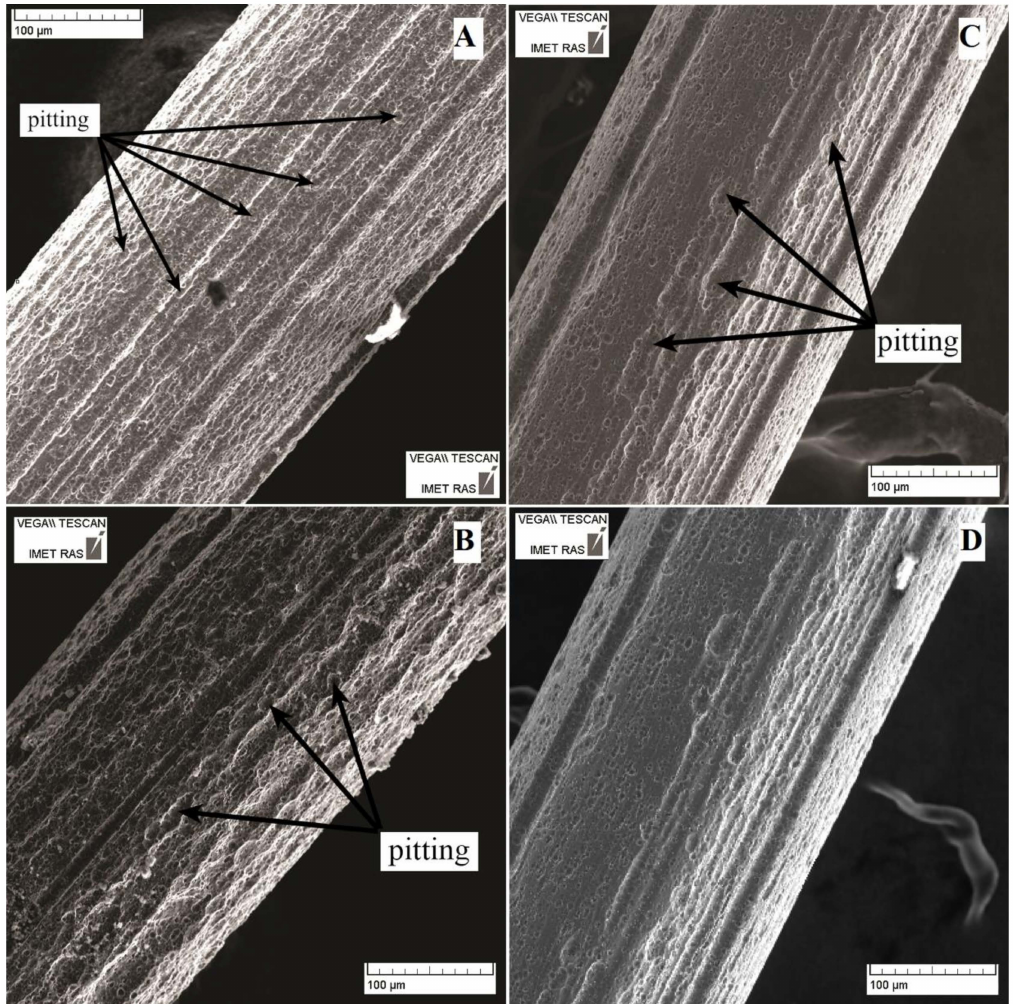
Figure 4. SEM image of the NiTi wire surface after two years of immersion testing in a bu ff er solution at pH 1.68 (Solution 1, Table 1): ( A ) as-received sample; ( B ) sample annealed at 450 ◦ C for 15 min; ( C ) sample mechanically treated in the direction of the long axis using diamond paste (3 µ m followed by 1 µ m) sample; and ( D ) sample mechanically treated and